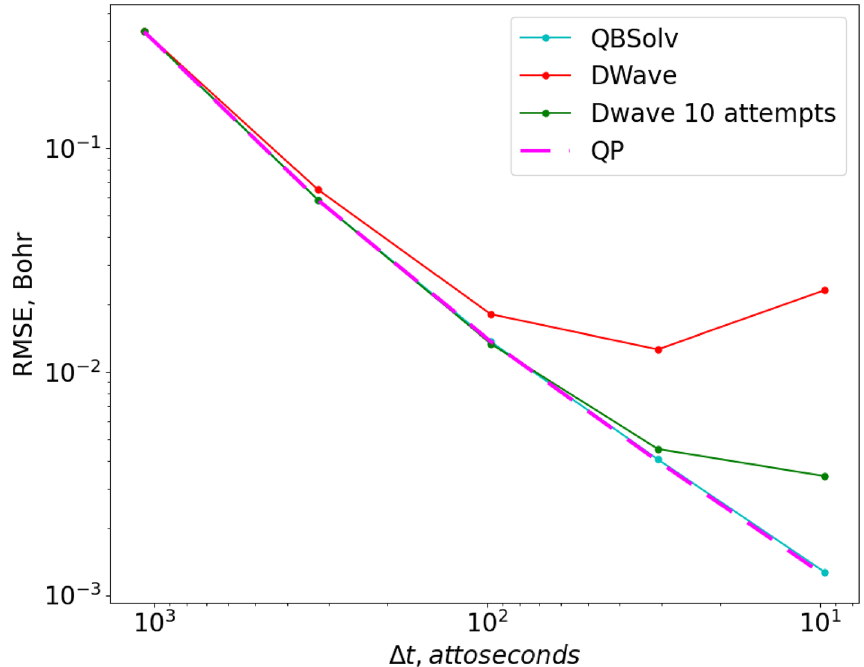
Figure 4. RMSE of solutions obtained with different methods as a function of the total number of grid points (or time steps). All methods propagate one equation at a